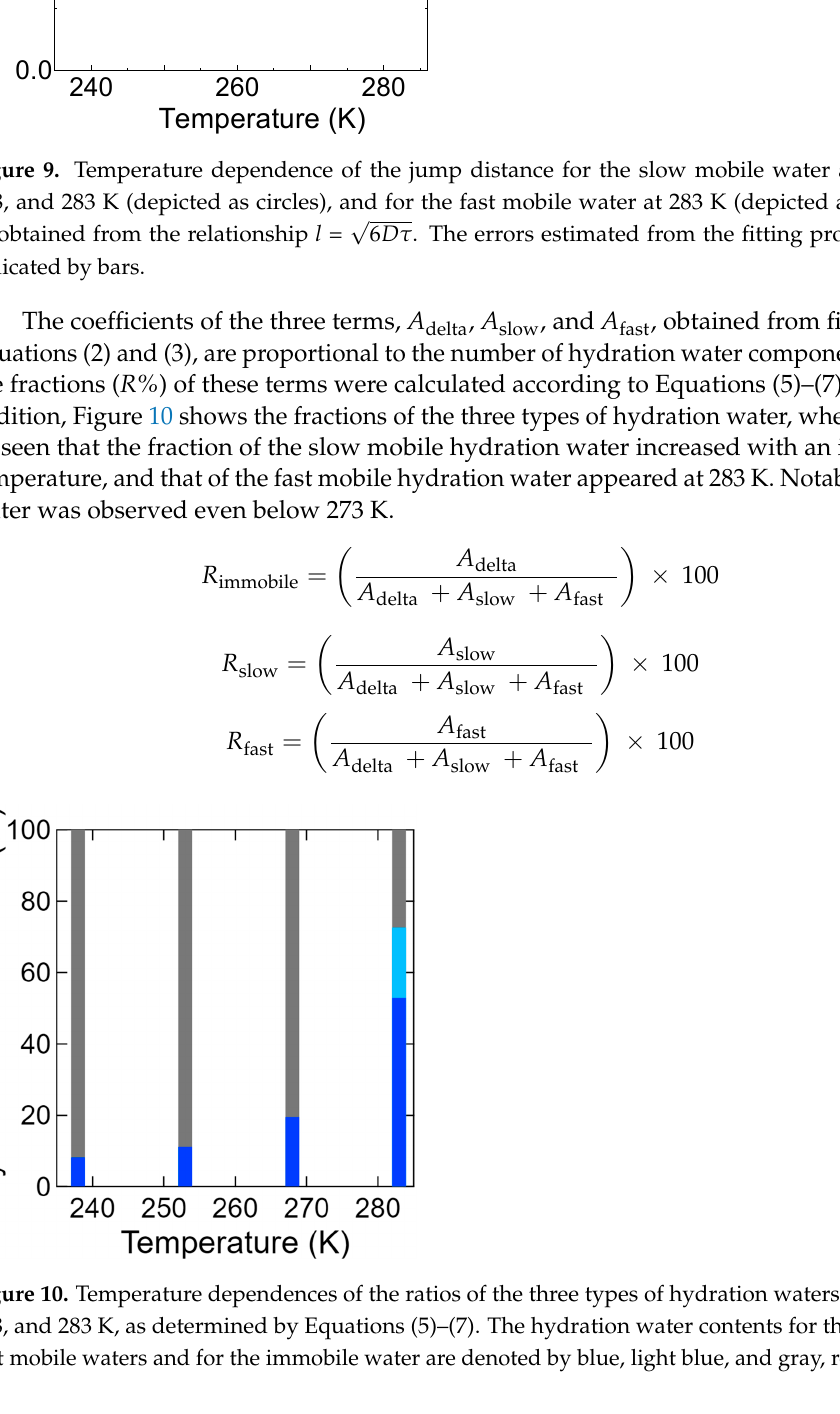
Figure 11. QENS spectra and fitted results of S D ( Q , ω ) with a resolution of 12 µeV at Q = 1.0 Å − 1 and at ( a ) 238 K, ( b ) 253 K, ( c ) 268 K, and ( d ) 283 K. The green points and red lines represent the observed intensities and the fitted curves. The black and blue lines represent the contributions from the delta and the Lorentz functions, respectively, which are convoluted by the resolution function. The ma- genta line represents the flat BG.